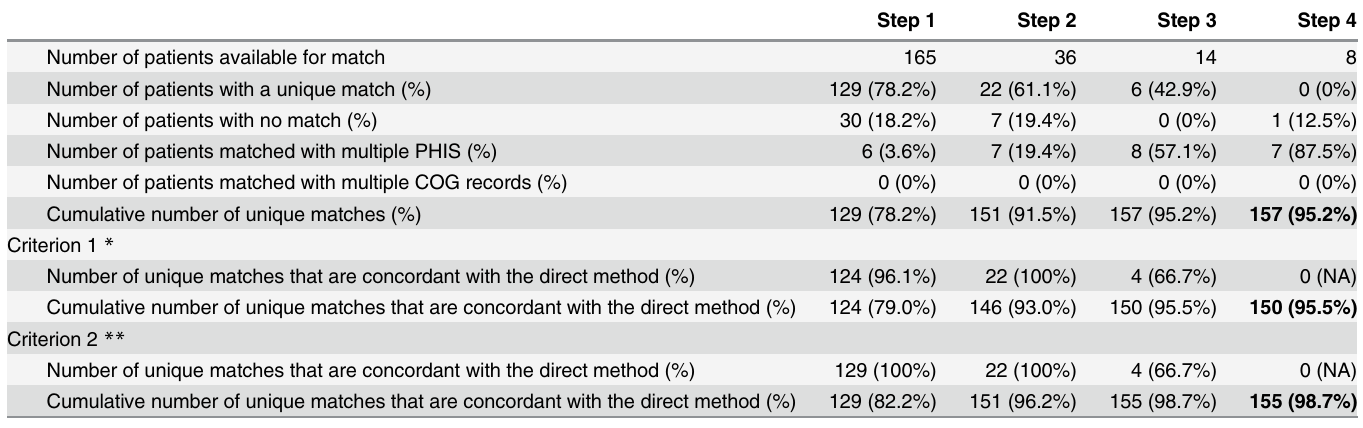
Table 4. Matching results using the indirect stepwise algorithm, validated on AAML1031. Note: The number of unique match from the direct merge method was 151